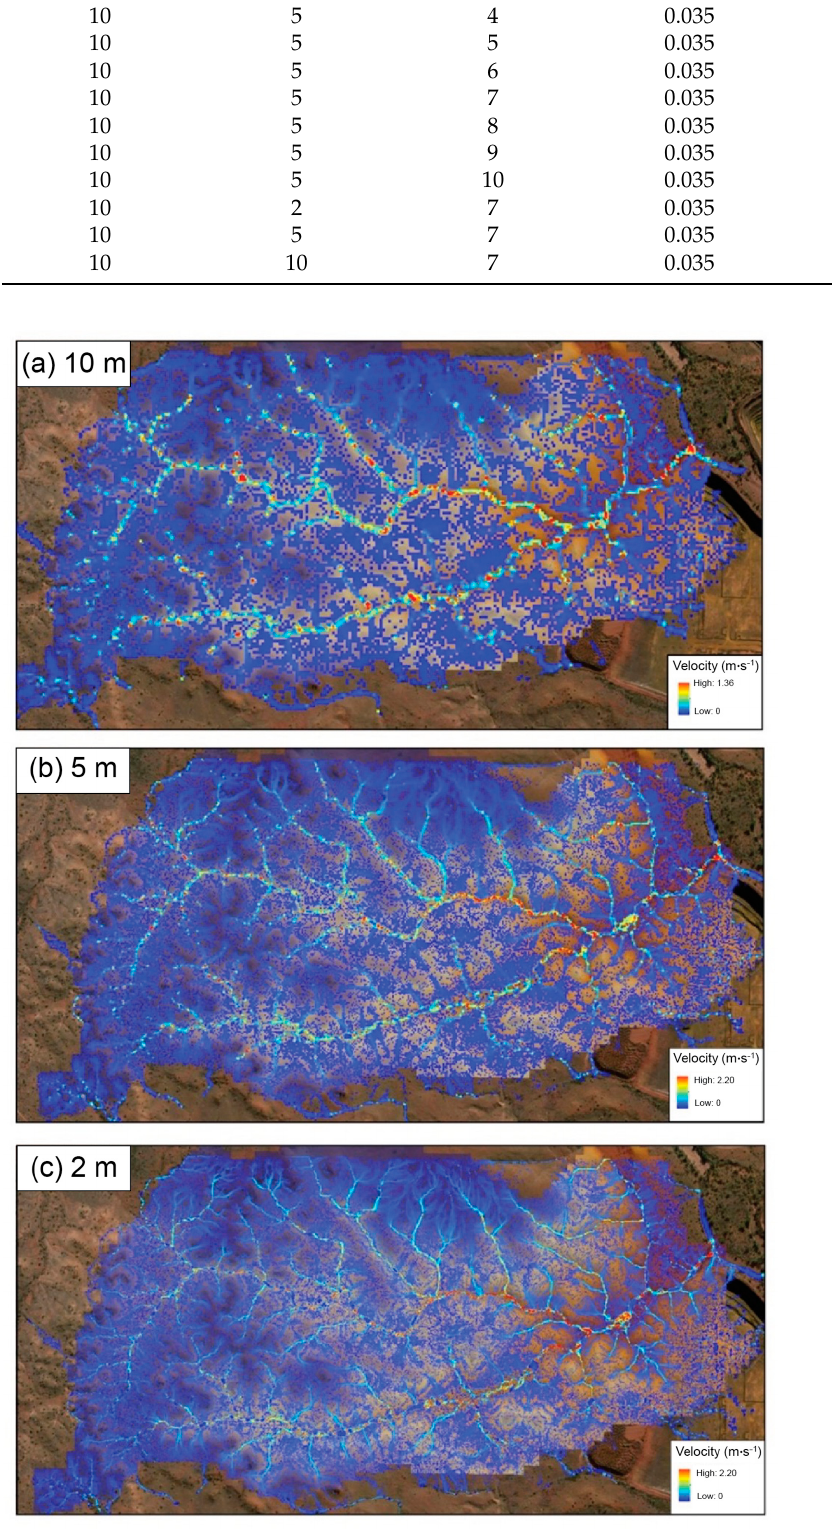
Figure 12. Effect of grid size variation in the direct rainfall model. Figure ( a ) shows 10 m grid, ( b ) 5 m grid and ( c ) 2 m grid sizing.